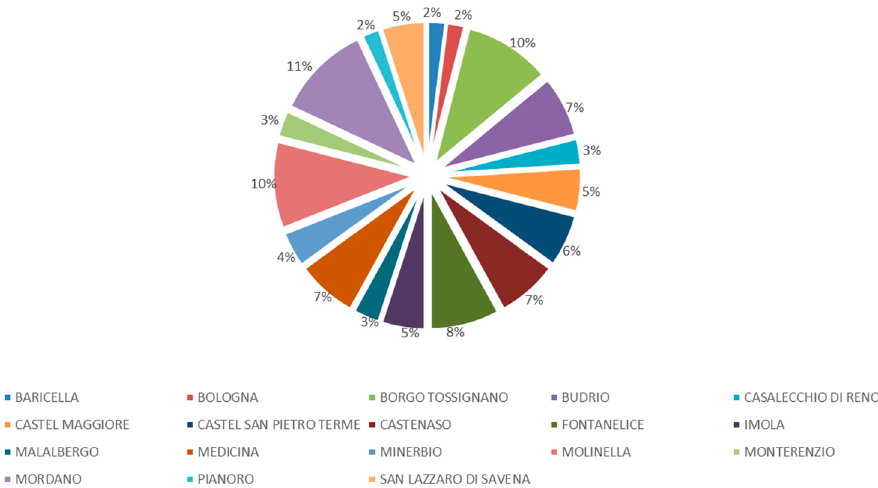
Figure 6. UCO specific production per capita in the selected municipalities.